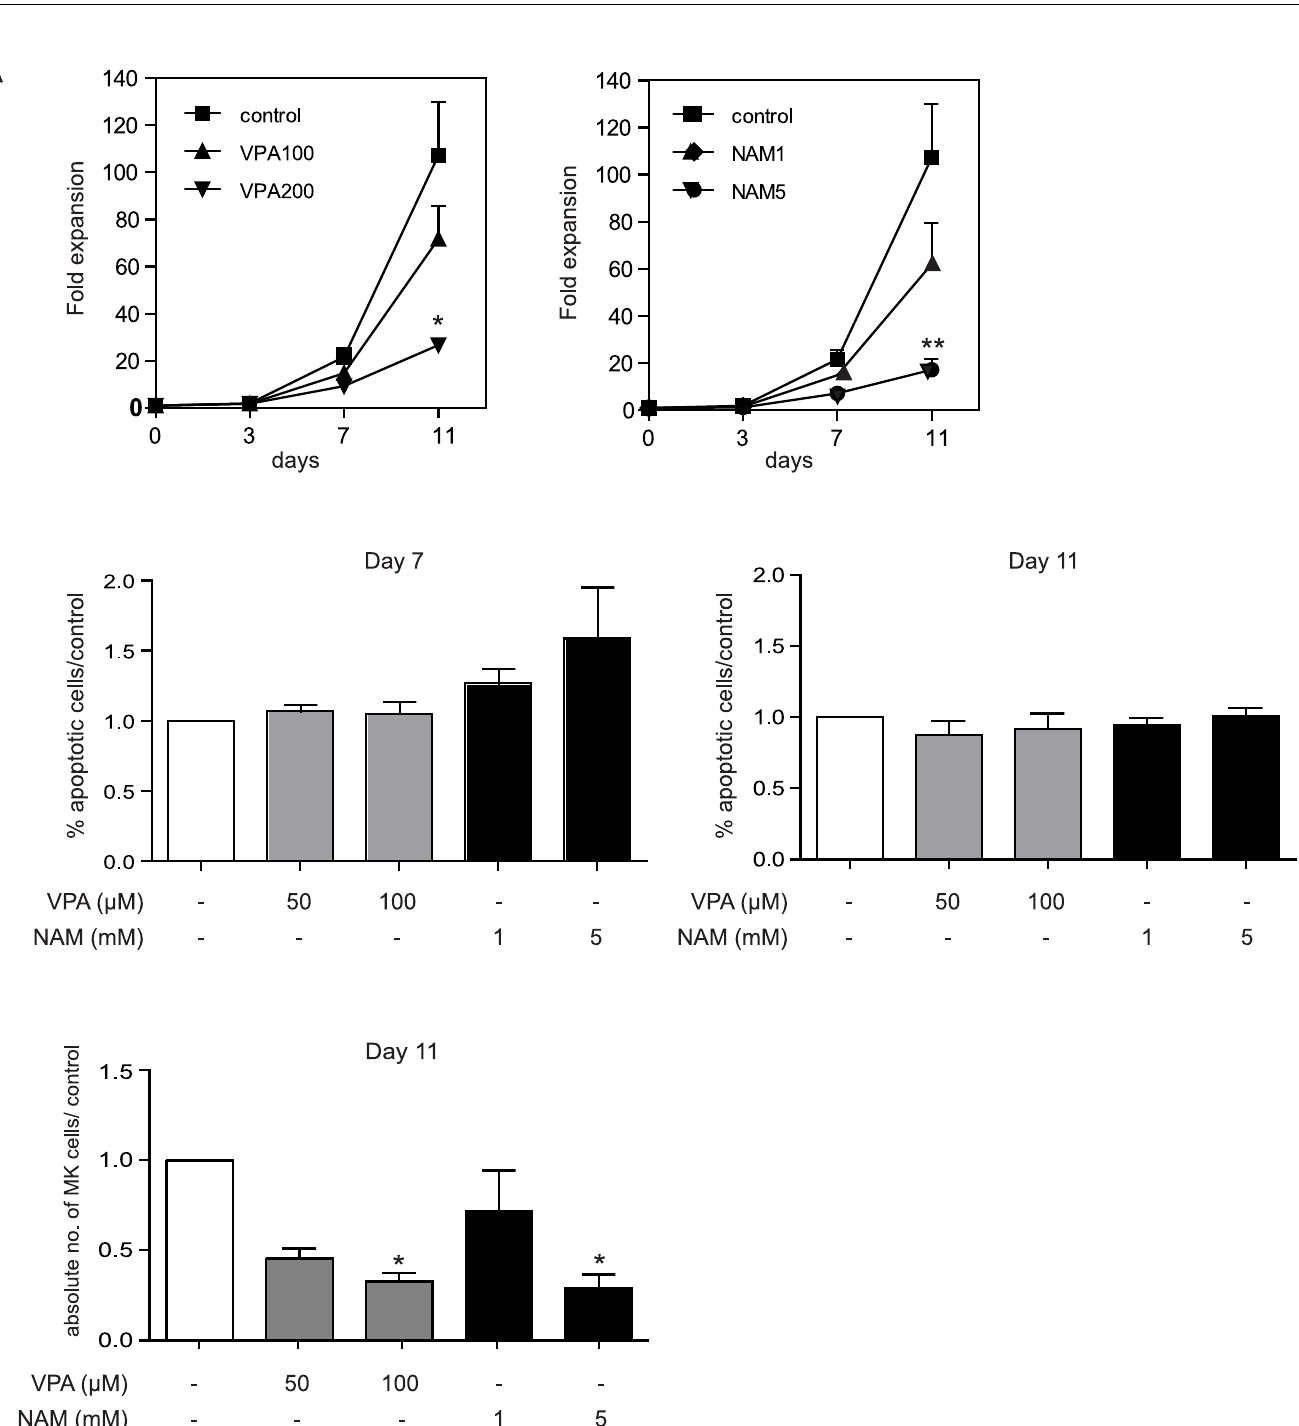
PLOS ONE | https://doi.org/10.1371/journal.pone.0196400 April 26,